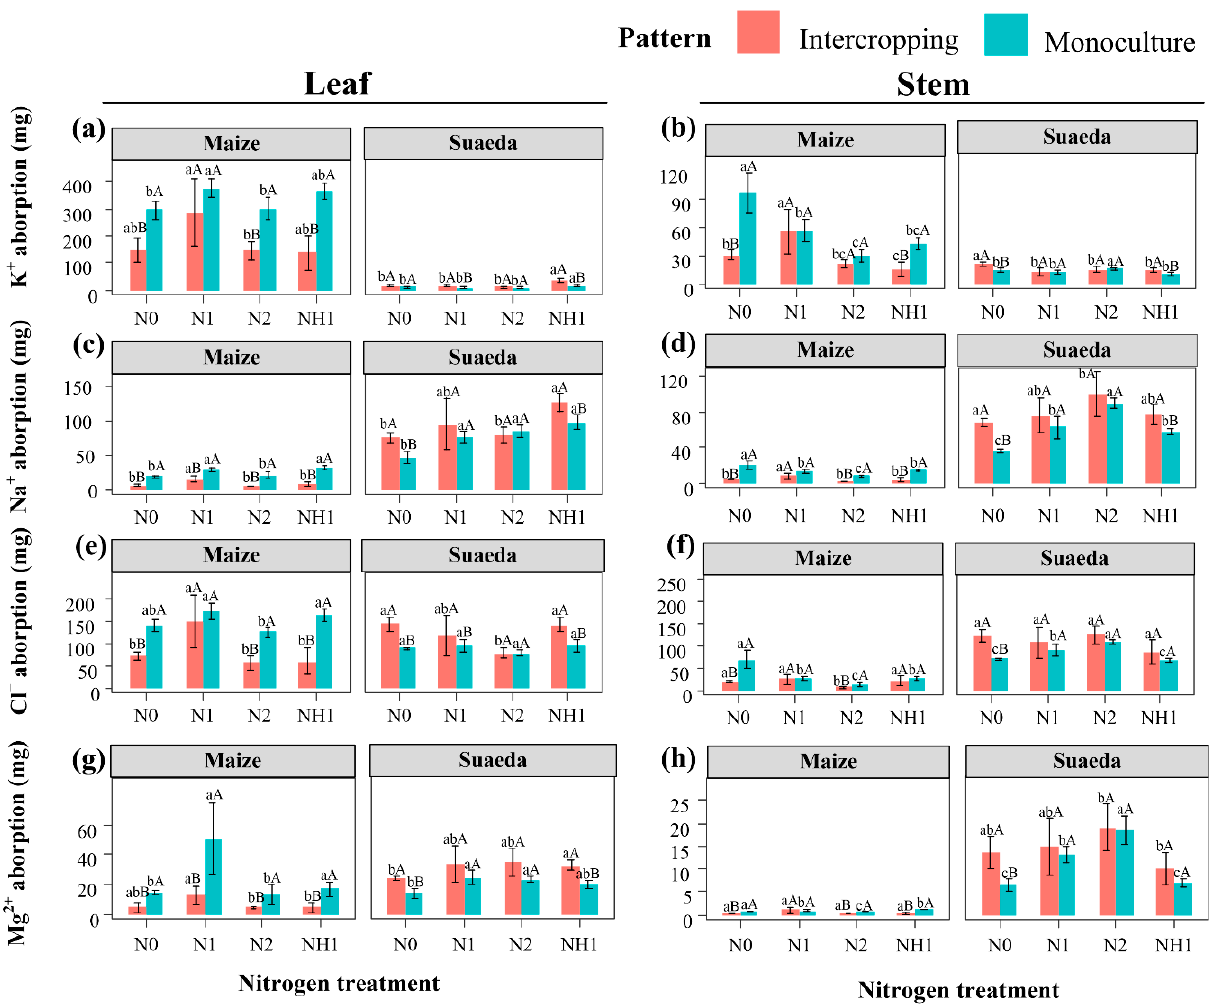
Figure 2. Effect of nitrogen treatment on K + ( a , b ), Na + ( c , d ), Cl − ( e , f ), and Mg 2+ ( g , h ) accumulation in leaves and stems of S. salsa and Z. mays L. in the different cropping patterns. Capital letters indicate the significant differences between two cropping patterns. Lower case letters indicate significant differences of four N treatments.